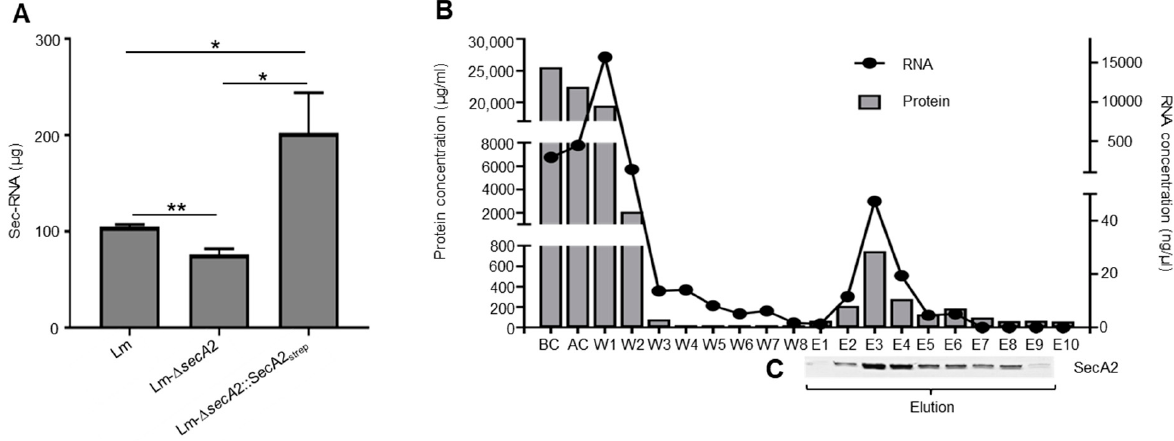
Figure 5. ( A ) Differences in the amounts of secreted RNA (sec-RNA) isolated from the supernatant of wild type Lm, Lm- ∆ secA2 and Lm- ∆ secA2 ::SecA2 strep ; ( B ) correlation between SecA2 protein concentration and its co-eluted RNA. Protein and RNA concentration of cytosolic fractions before (BC), after (AC) passing through the streptactin chromatography column, in wash steps (W1-W8) and elution fractions (E1-E10); and ( C ) the corresponding coomassie gel for SecA2 protein. Data are presented as means ± SD of results from three experiments * p ≤ 0.05; ** p ≤ 0.01.